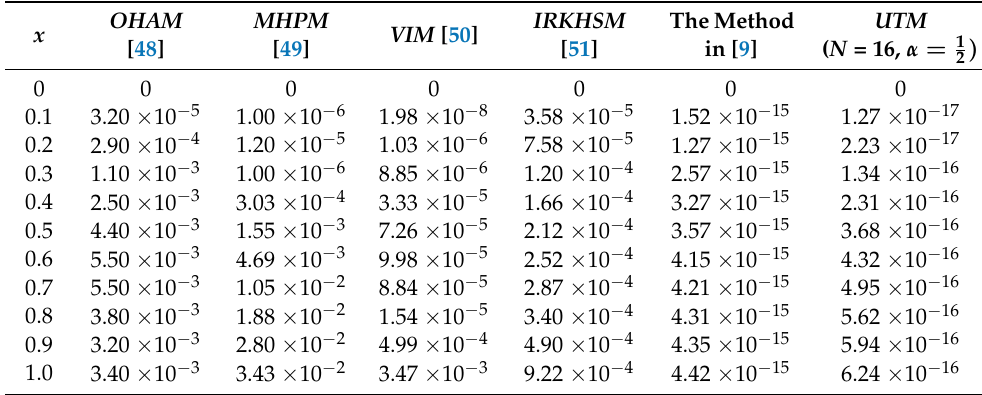
Table 2. Comparison between different methods for Example